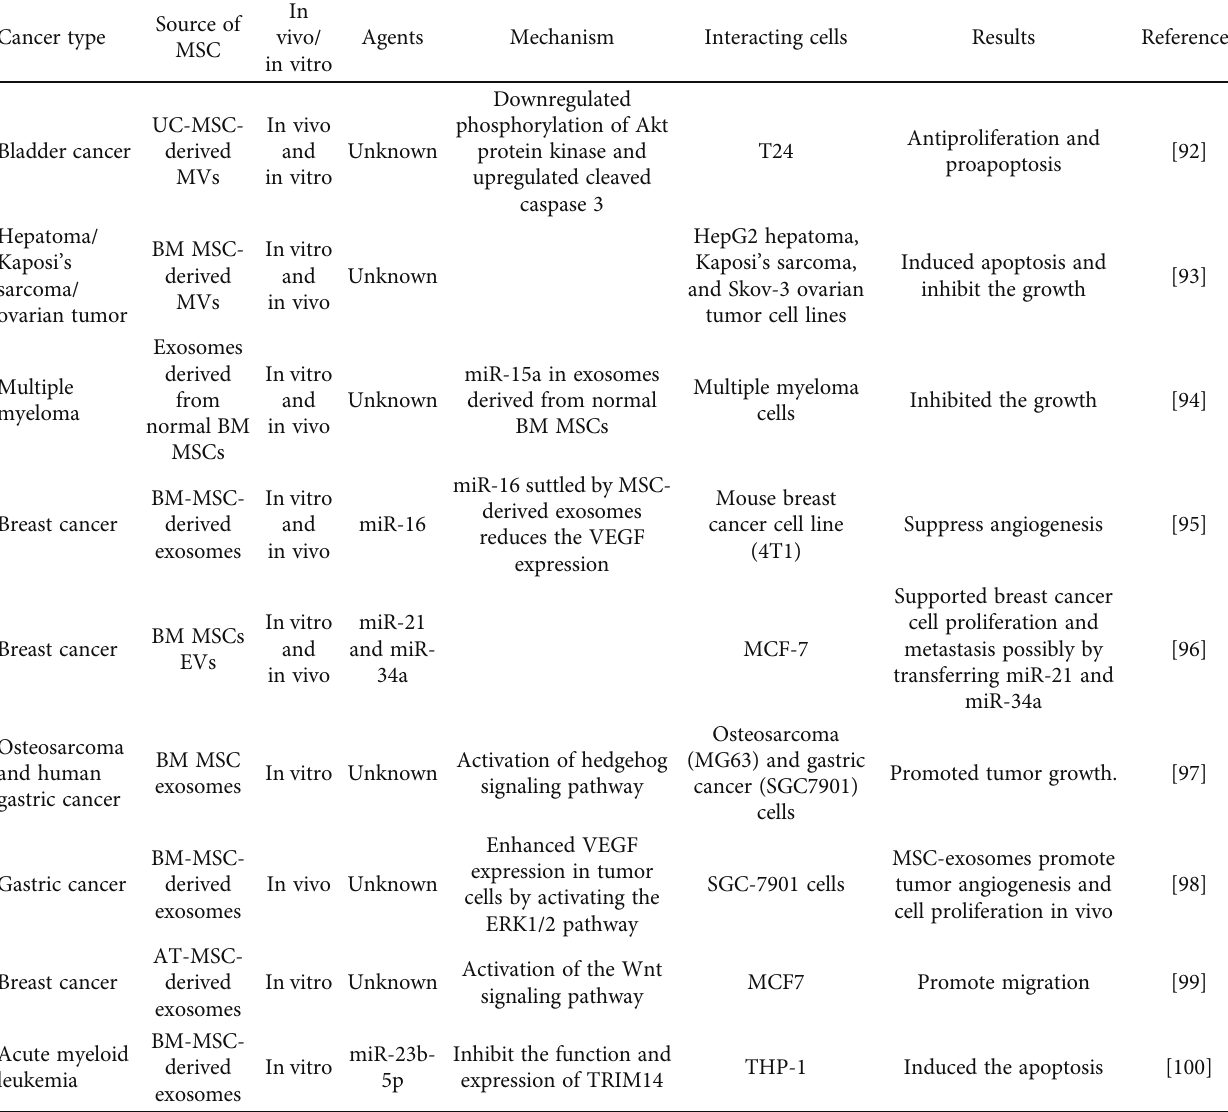
Table 5: E ff ect of MSC extracellular vesicles EVs/exosomes on